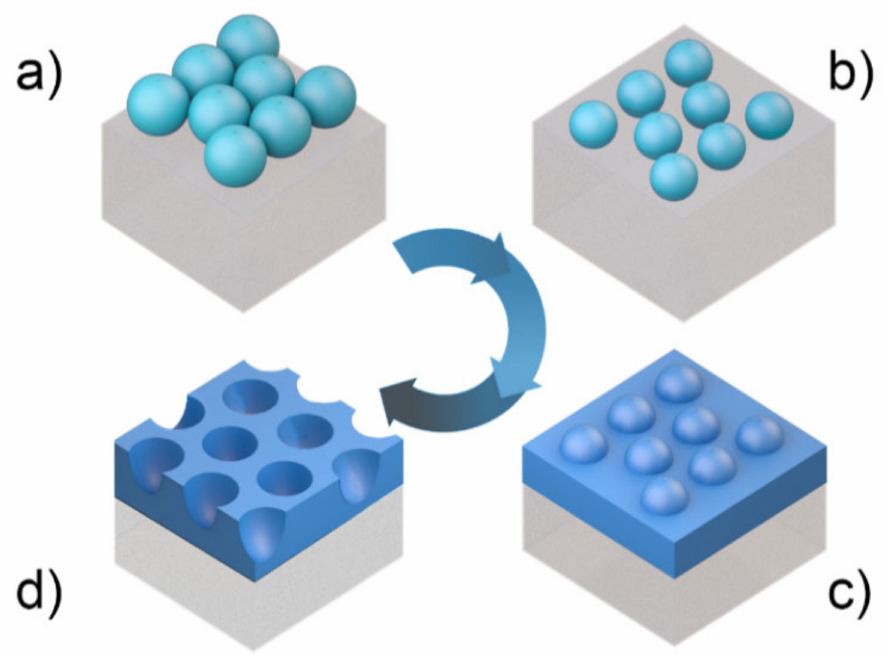
Figure 2. Illustration of the colloidal lithography (CL) main steps, depicting the sequence of ( a ) the deposition of colloidal particles on a surface, ( b ) reactive ion etching (RIE) for particle shap- ing, ( c ) material deposition, and ( d ) lift-off of the colloids leaving only the patterned material on the